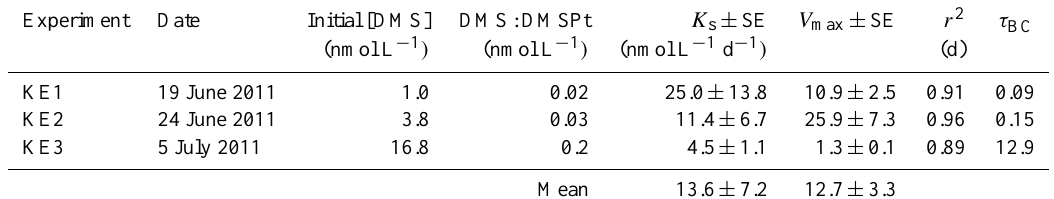
Table 2. Kinetic parameters ( K s (half-saturation constant), V max (maximum 13 C-DMS consumption rate)) and turnover time of DMS due to BC ( τ BC ) for 13 C-DMS loss rates at three contrasting sites in NW European shelf waters. Kinetic parameters were calculated by fitting data to the Michaelis–Menten equation through non-linear regression of loss rate vs. 13 C-DMS concentration data from three kinetic experiments (See Fig. S4 in the Supplement). Initial in situ DMS concentrations measured at 0 h of each kinetic experiment are also shown.